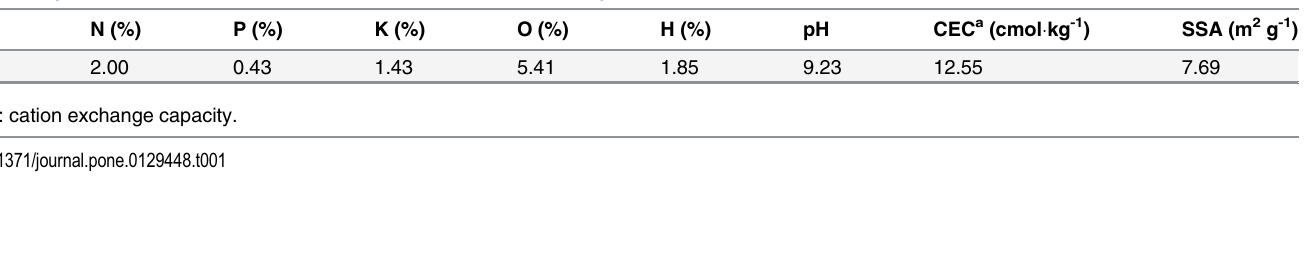
Table 1. Physical/chemical characteristics of biochar used in this